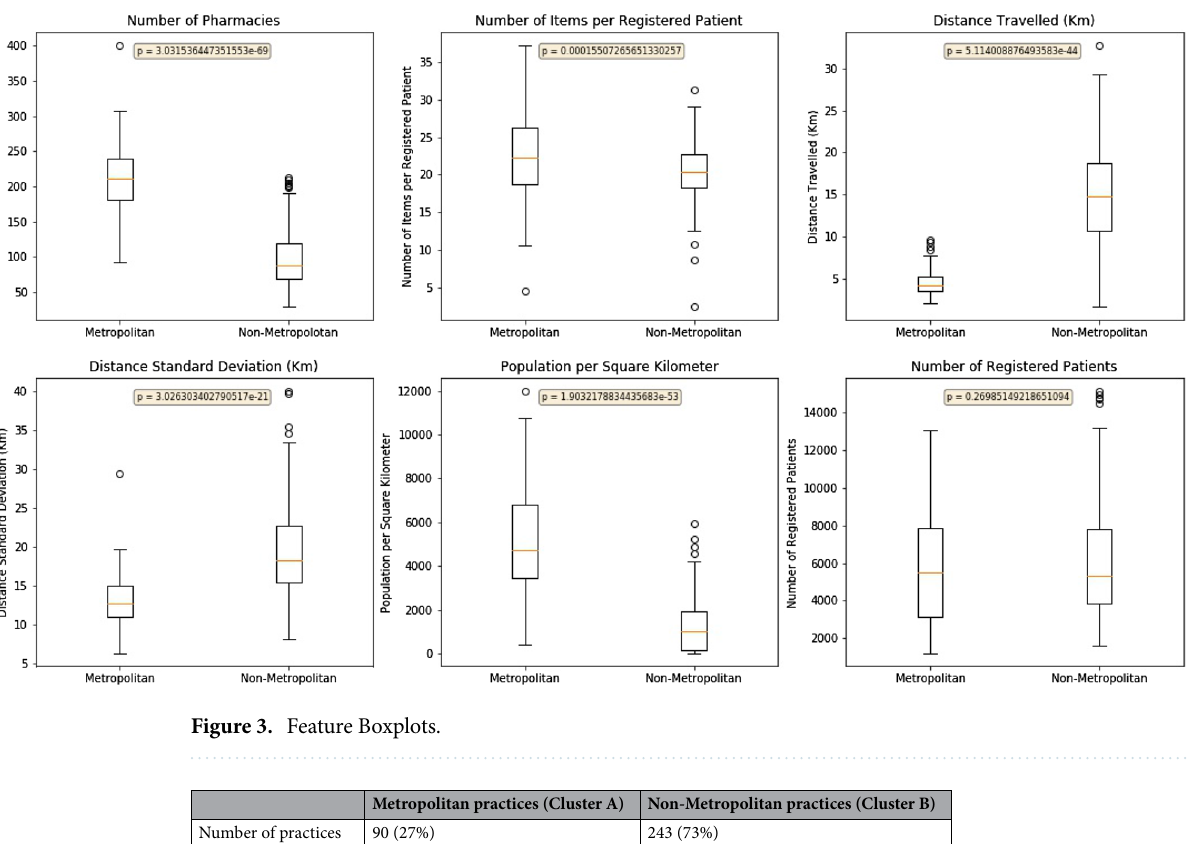
Figure 3. Feature Boxplots.